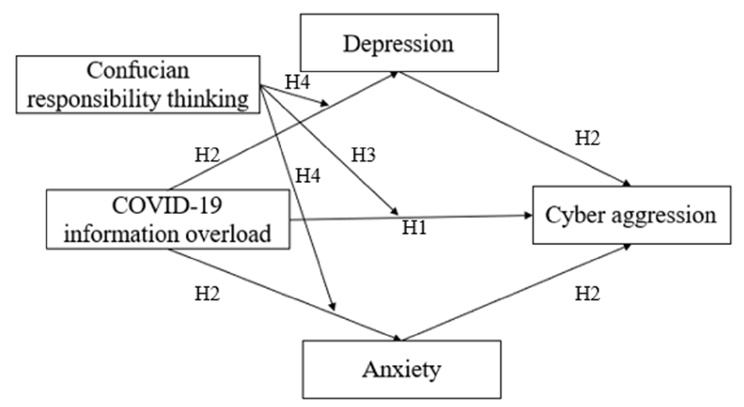
Figure 1. The proposed, moderated double-mediation model.